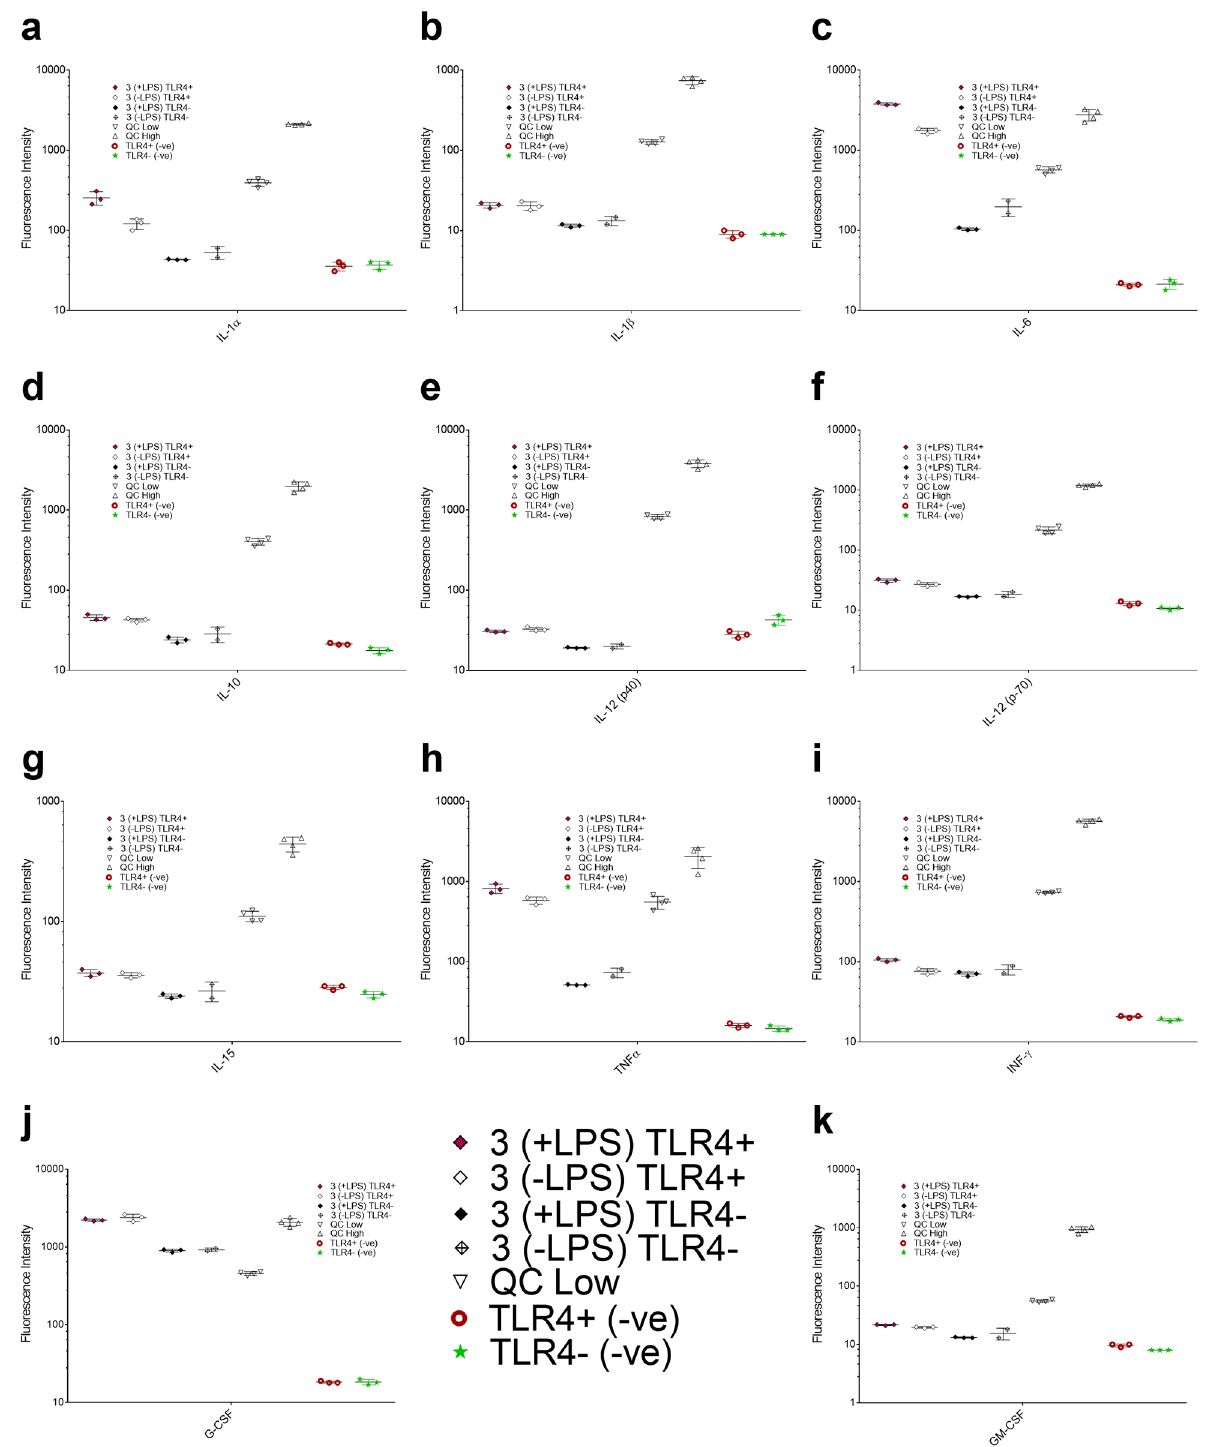
Fig 5. Comparison of cytokine response in condition 3 between TLR4(+) cells and TLR4(-) cells. Results of three independent replicates, plotted as fluorescence intensity for each individual cytokine, with error bars indicating the standard deviation of the mean for each condition. QC High and QC Low were high and low quality controls of unknown concentration, which were provided by the manufacturer. The negative cell controls indicate basal cytokine expression of the cells in normal growth conditions with no LPS. Each subset (a-k) is a graph of an individual cytokine as indicated on the x-axis. Y-axis is plotted on a logarithmic scale to allow for viewing a large range of values on a single plot.